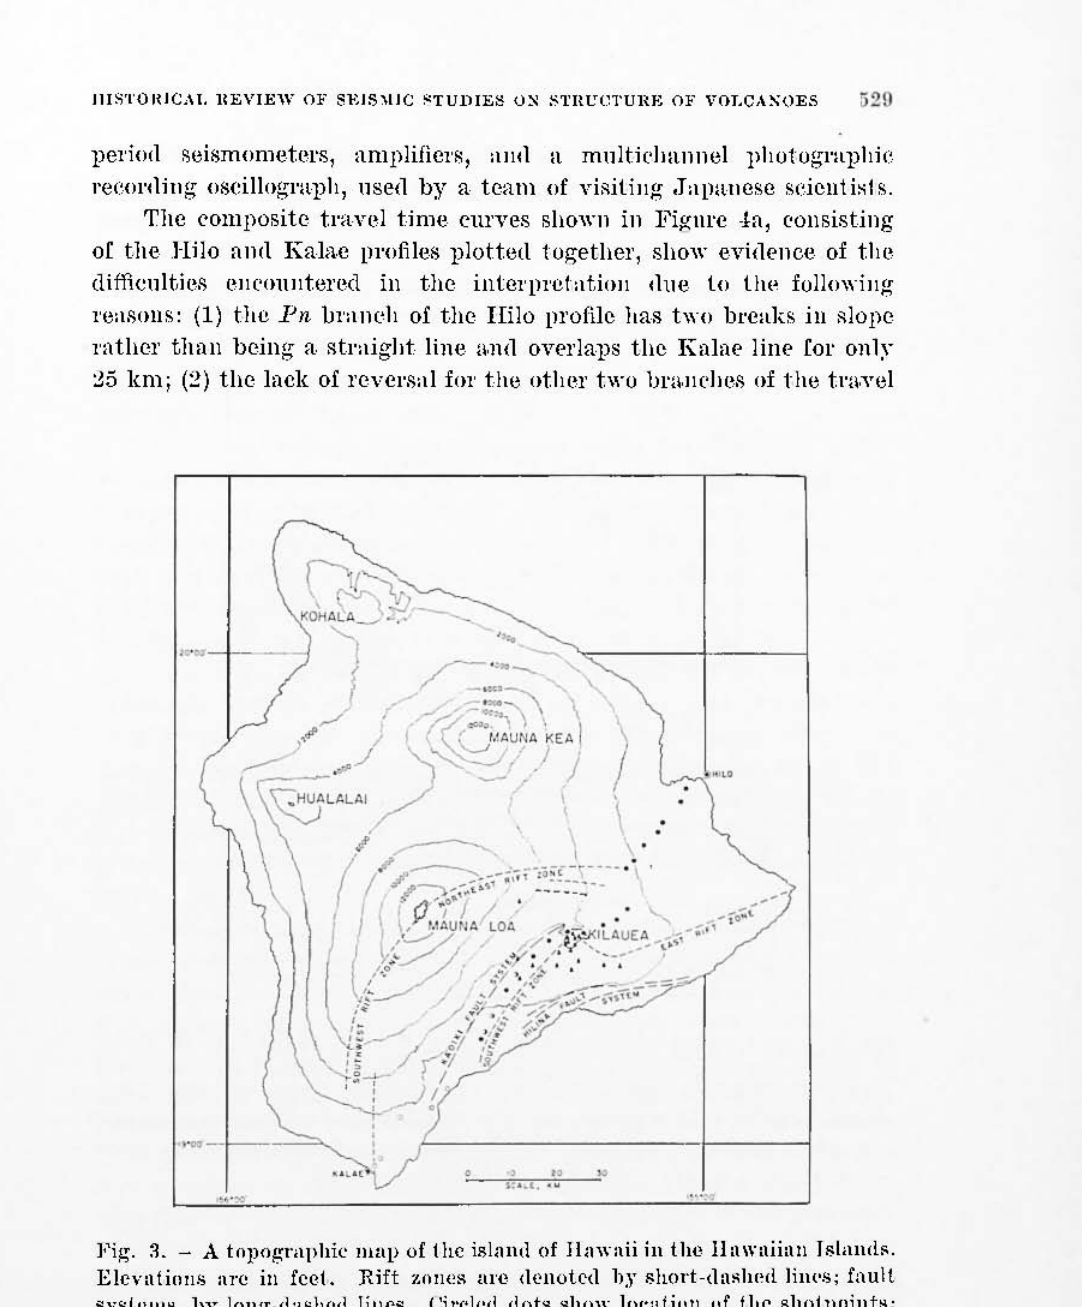
Fig-. 3. - A tOI)ogTaphie IlWp of tltc isl~u\(l of lInwaiÌ ill the llawaiian Jslal\(l~. Elcvatiolls arc in